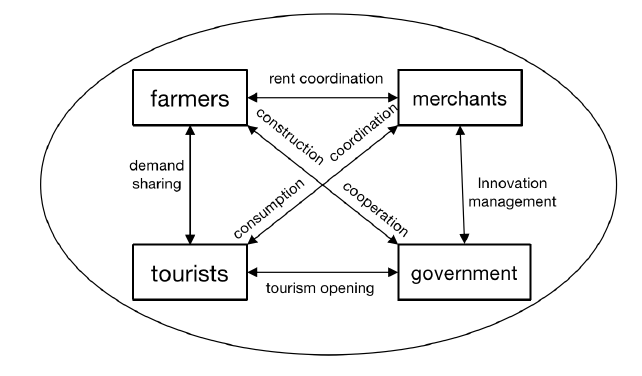
Fig. 1. Figure with village and landscape linkage